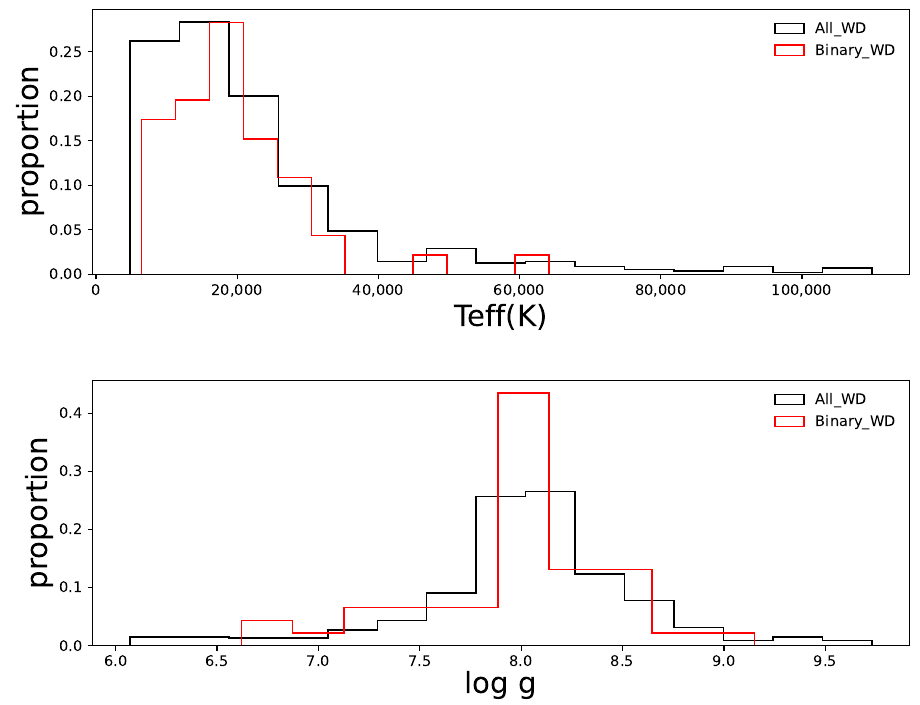
Figure 5. Histograms of T ef f and log g ; the vertical coordinate indicates the percentage. Black: WD single stars. Red: WD binary